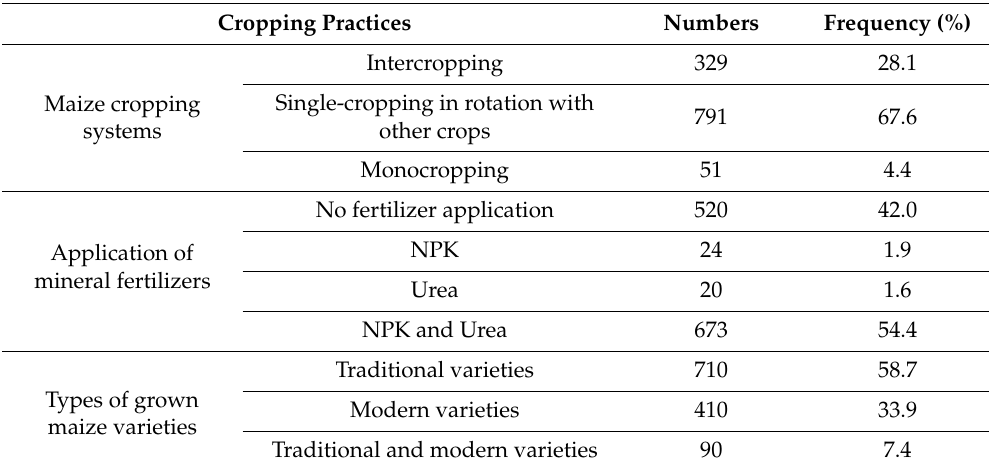
Table 5. Farmers’ cropping